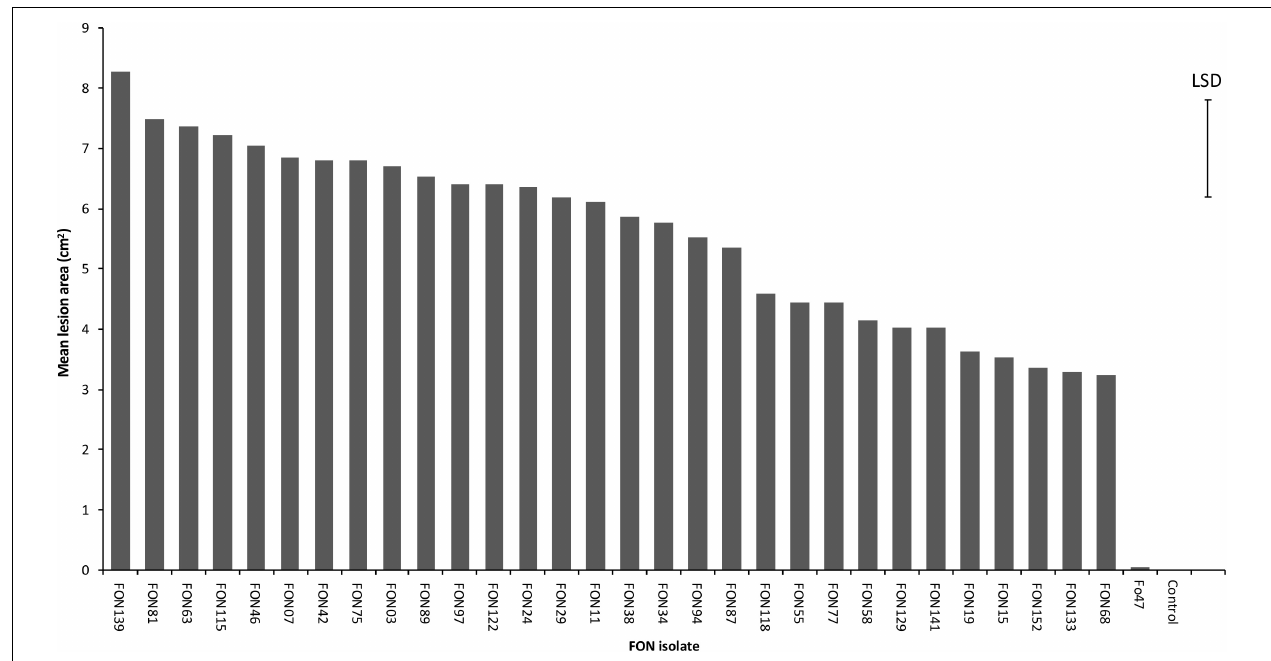
FIGURE 1 | Virulence of 30 Fusarium oxysporum isolates against Narcissus (cv. Carlton) as measured by mean lesion area at 20 dpi (cm 2 ). The error bar indicates the maximum LSD (5% level) following ANOVA. Standard error values ranged from 0.20 to 0.87 with a mean of